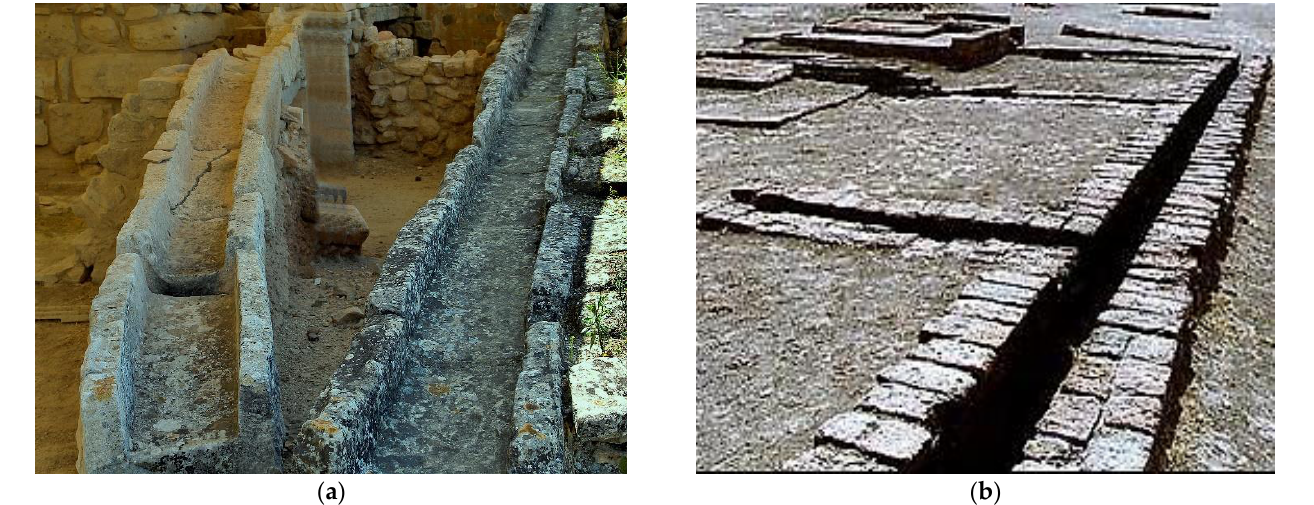
Figure 2. Sewerage and drainage systems: ( a ) Minoan (photo: A.N. Angelakis) and ( b ) Indus Valley [15,20].